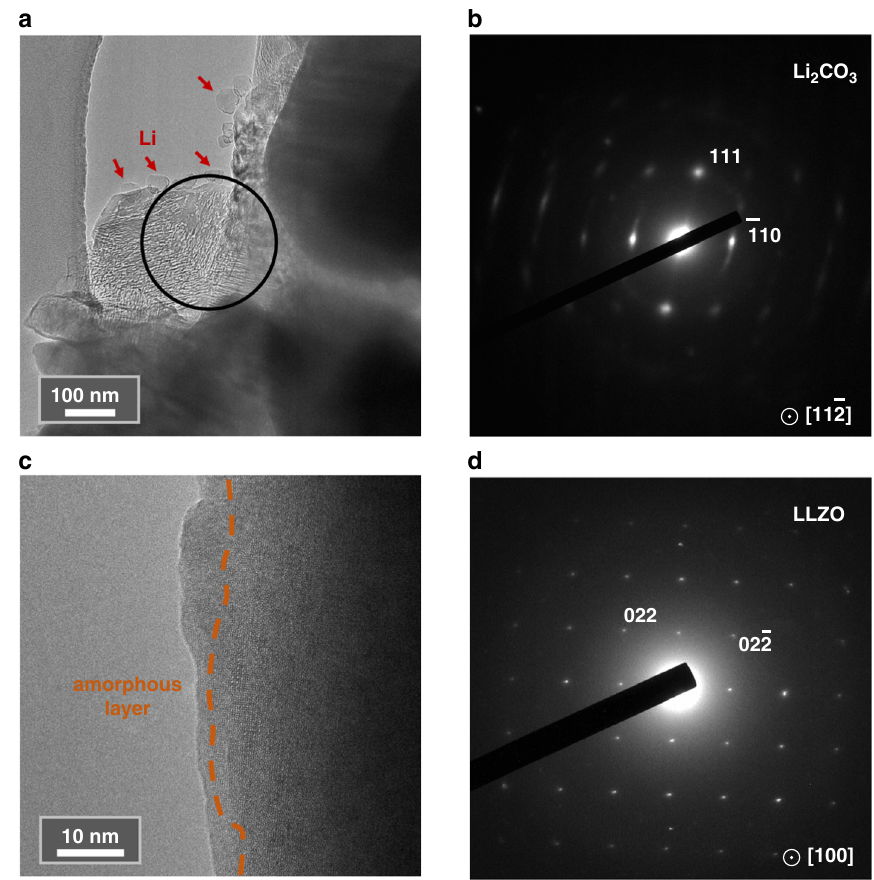
Fig. 5 Lithium growth from the surface contamination layer of LLZO. a Lithium particles (indicated by red arrows) grown from lithium carbonate contamination layer. Black circle represents the selected area for SAED in ( b ). b the SAED pattern is indexed to be Li 2 CO 3 . c No lithium particle growth can be observed on pure surface of LLZO upon electron irradiation. Orange dotted lines mark the amorphous layer caused by irradiation. d SAED of the region in ( c ) is indexed to be